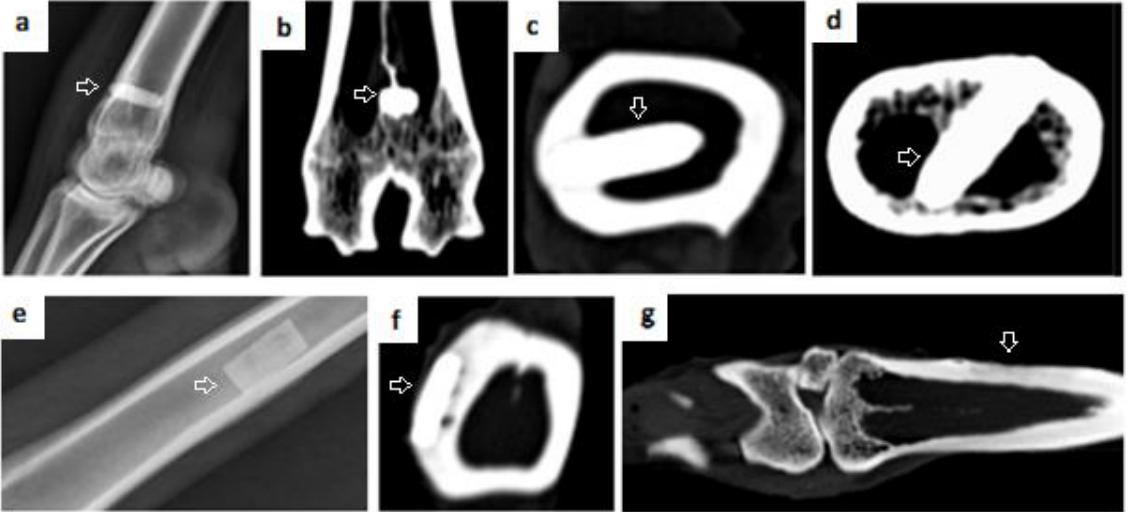
Figure 8. X‑ray and CT scans 6 months after implantation. ( a ) X‑ray of metatarsal bone after HA cylinder implantation ( b – d ) CT scans after HA cylinder implantation. ( e ) X‑ray after application of nonperforated plate. ( f ) CT scan of nonperforated HA plate fixed in metatarsal bone. Arrows in figures a-f point to the site of the defect and the implant that was not resorbed. ( g ) CT scan of new bone formed after resorption of the perforated HA plate, arrow: shows newly formed bone tissue after HA plate resorption.